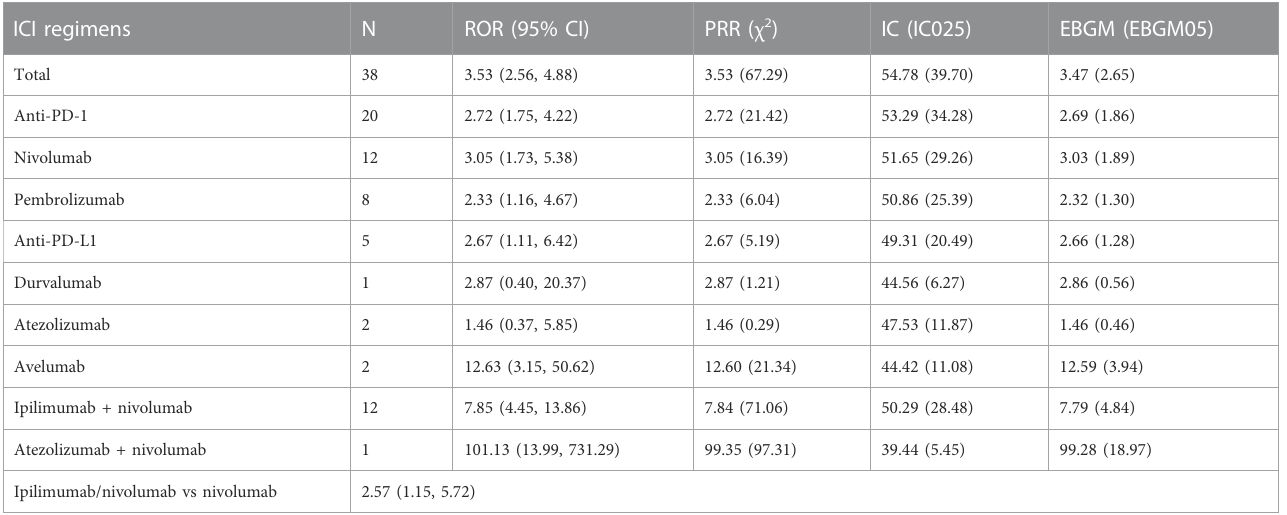
TABLE 4 Associations of different ICI regimens with aplastic anaemia. ICI